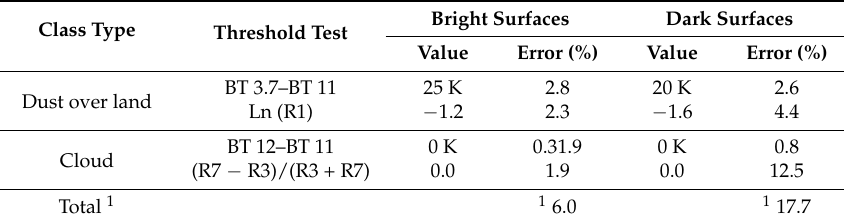
Table 5. The tests and thresholds used for detecting dust storms; and the sensitivity analysis based on the selected dust storm events in China during the period of 2001–2007.